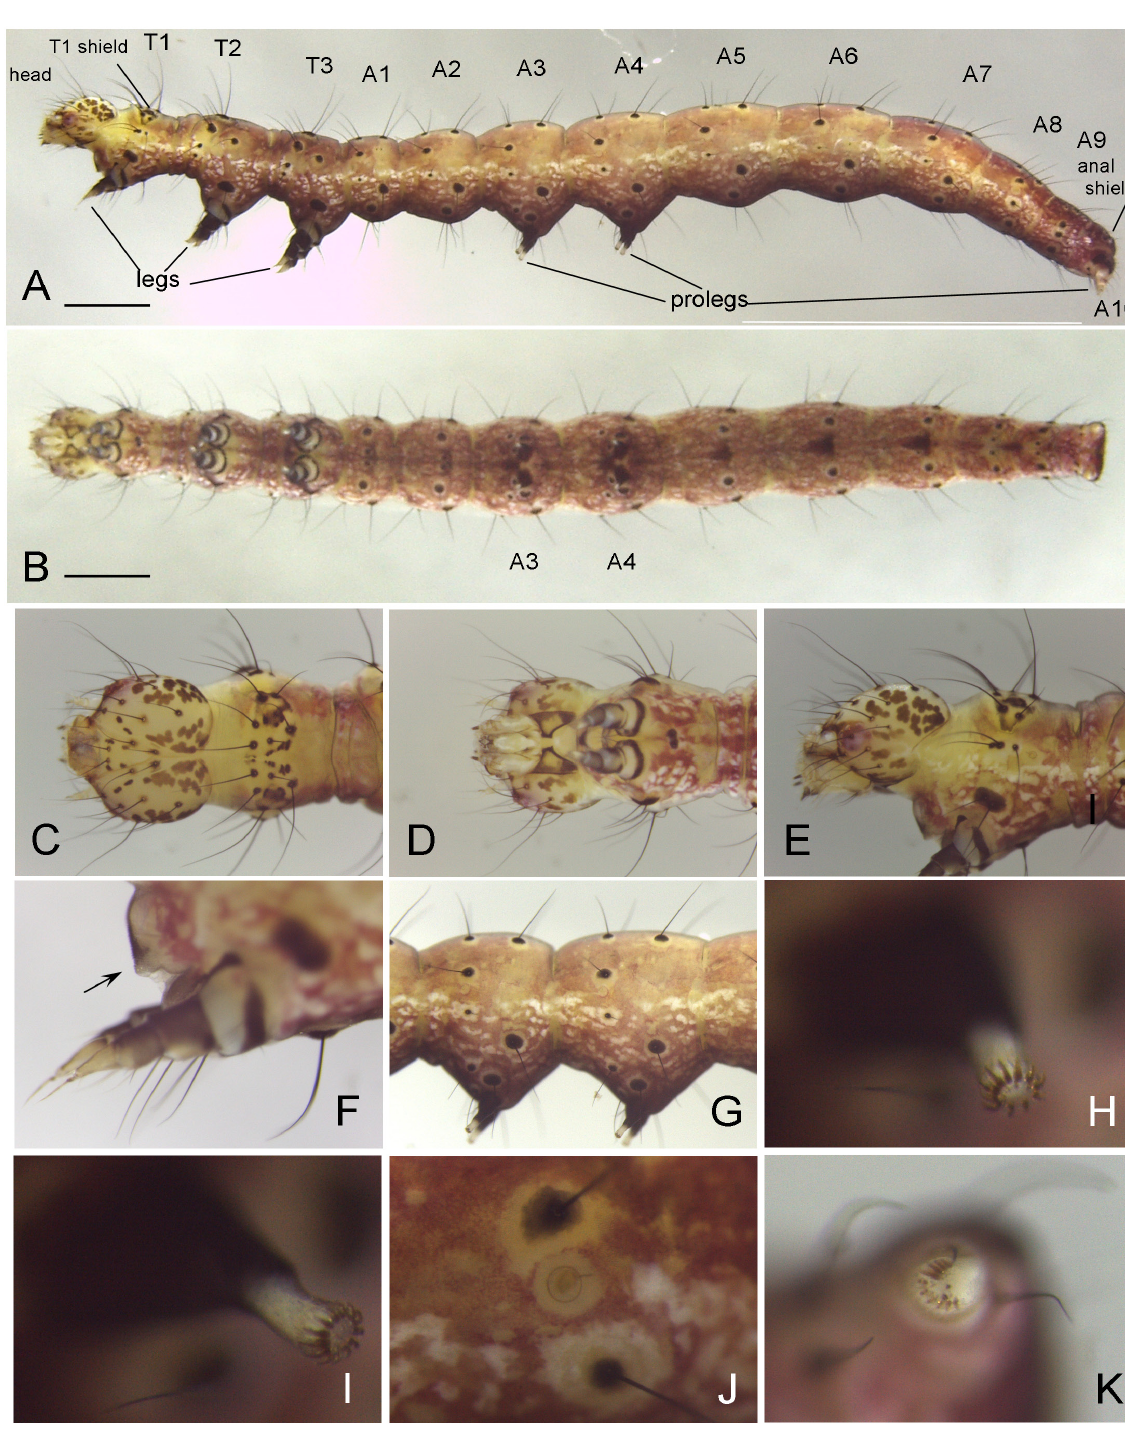
Fig. 4. Mature larva of Tonza citrorrhoa Meyrick, 1905 (OPU-IN-LE2018IV0031|SK600). A . Gene - ral, lateral view. B . Same, ventral view. C . Head and prothorax, dorsal view. D . Same, ventral view. E . Same, lateral view. F . Jugular glands, lateral view. G . A3, 4. H . Proleg on abdominal segment 3. I . Same, on abdominal segment 4. J . Spiracle on abdominal segment 8. K . Anal proleg, ventral view. Scale bar: 1